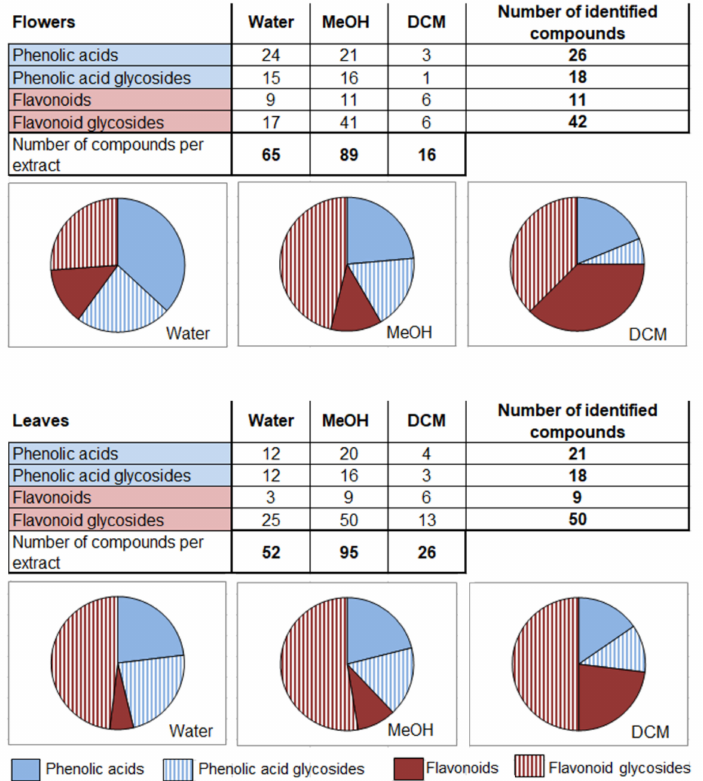
Figure 1. Number of identified phenolic acids, phenolic acid glycosides, flavonoids, and flavonoid glycosides in water, methanol (MeOH), and dichloromethane (DCM) extracts of flowers and leaves of French marigold. Pies represent relative distribution of different groups of phenolics in each extract (number of compounds per extract =